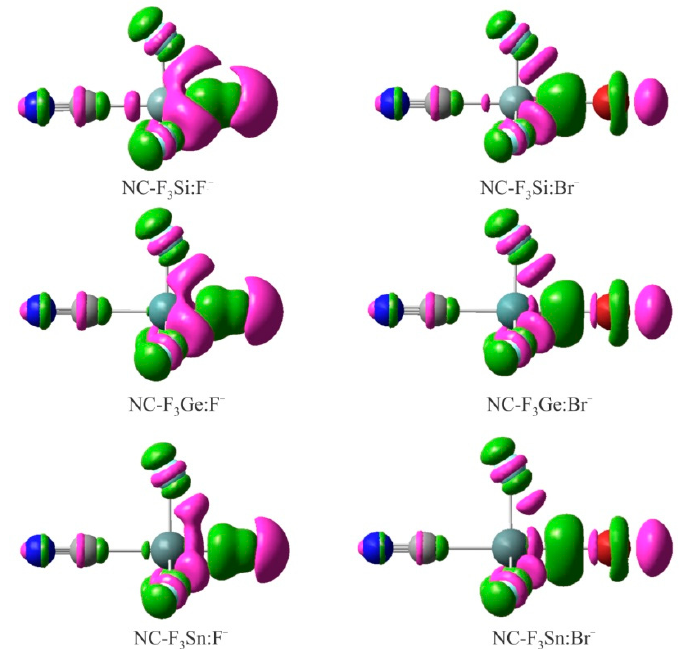
Figure 4. EDD isosurfaces (±0.005 au) of some representative XF 3 M:A − complexes. The violet and green regions indicate regions of decreased and increased electron densities, respectively.